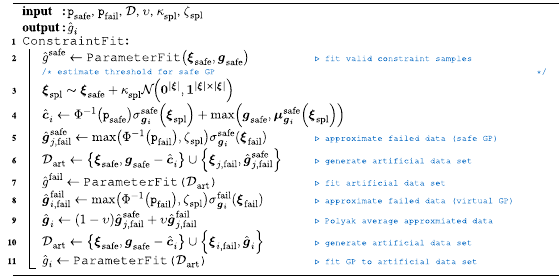
Algorithm 1. Given the structure of the factor graph and the